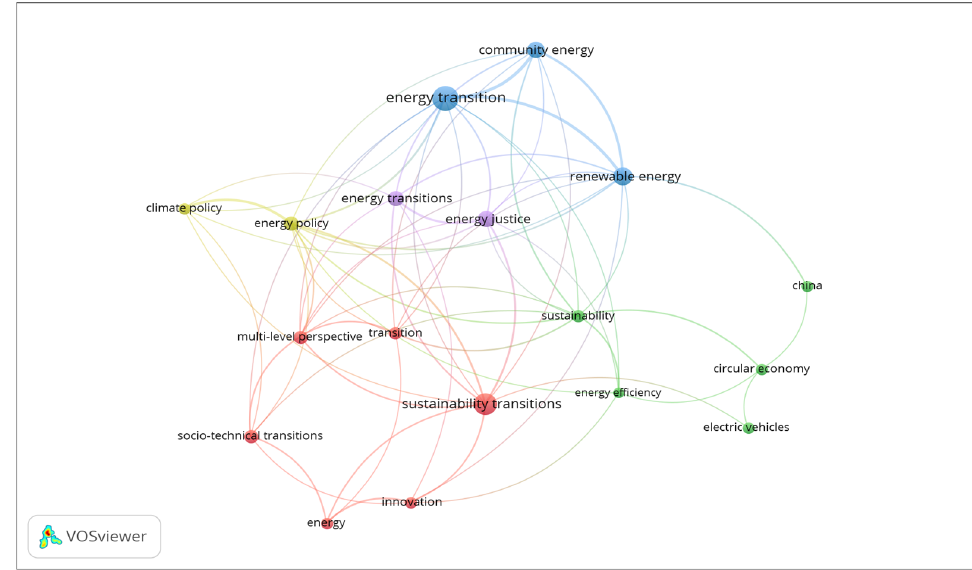
Figure 5. VOSviewer diagram containing the most important author keywords, for the couple: social innovation–energy transition.